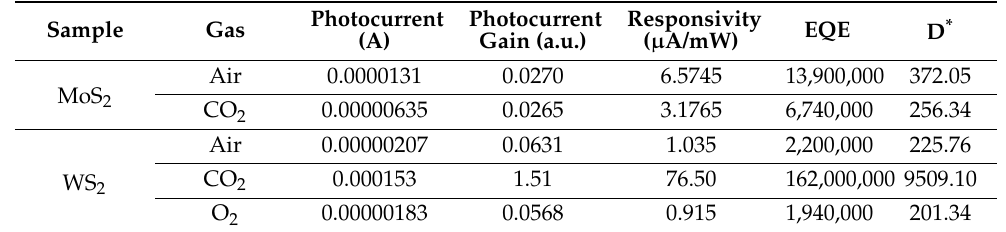
Table 3. The photocurrent (I ph ), photocurrent gain (P g ), photoresponsivity (R λ ), external quantum